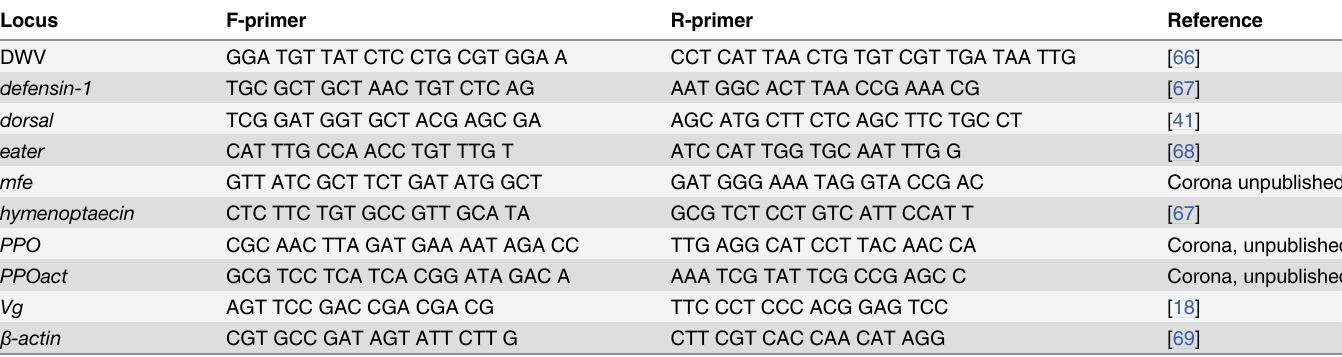
Table 1. Primers used for